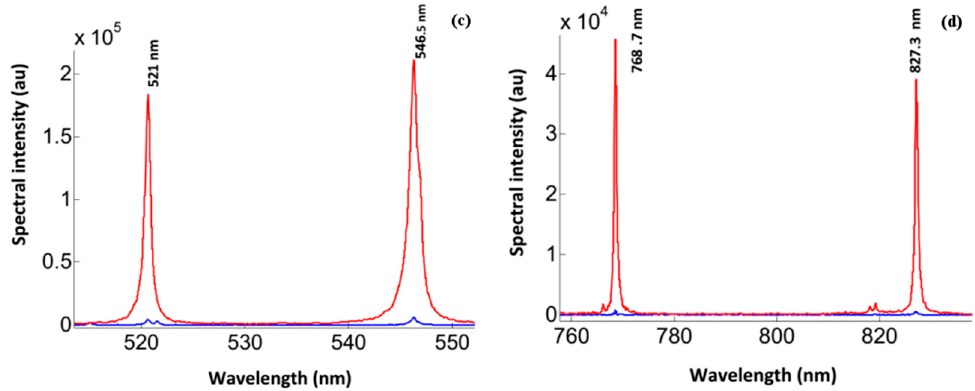
Figure 1. ( a – d ) Emission spectra at different wavelength regions from nano-based silver target (in red) and bulk target plasma (in blue).